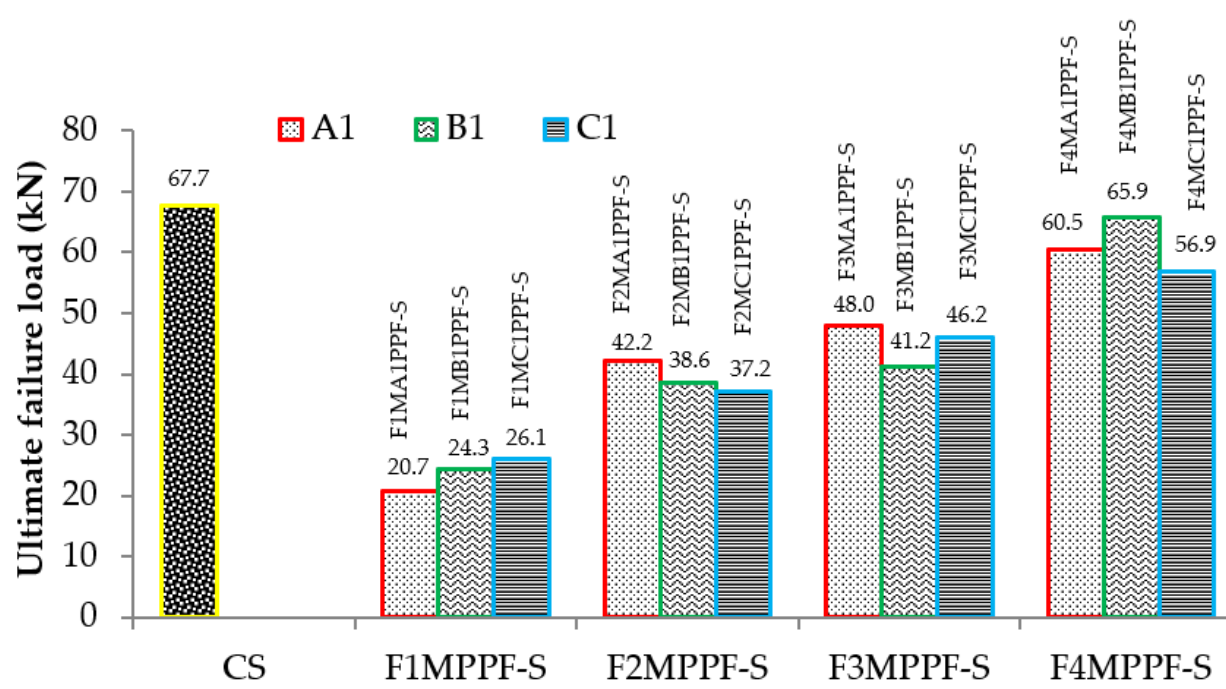
Figure 10. Ultimate load results of ferrocement & RCC slab.